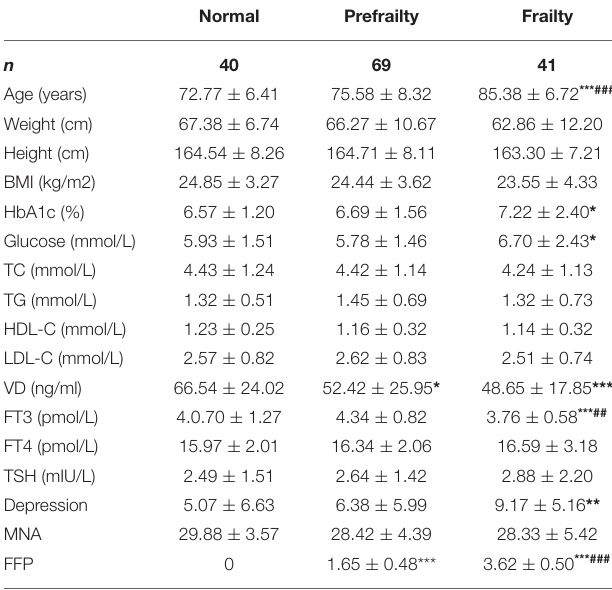
TABLE 1 | Anthropometrics, depression assessment and Fried Frailty Phenotype (FFP) of the participants.